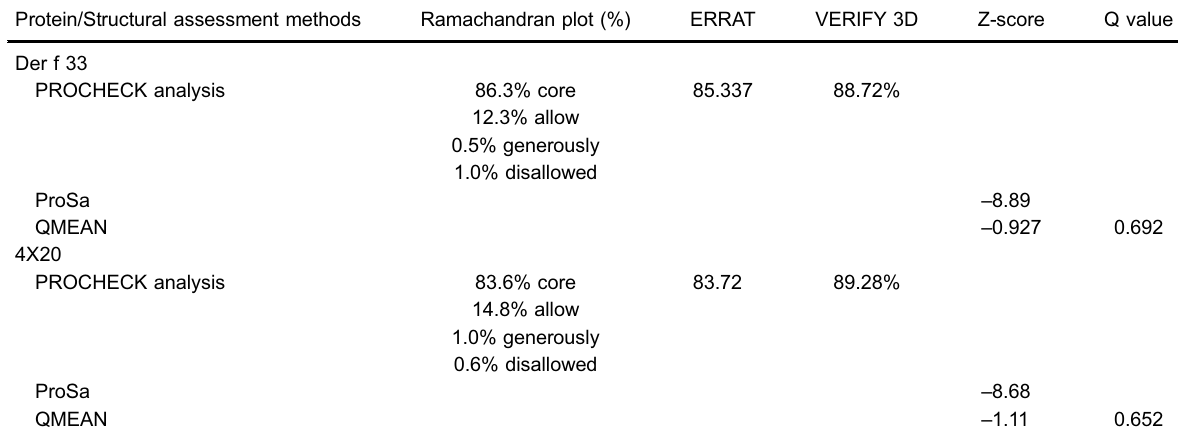
Table 1. Parameters of Der f 33 tertiary structure.